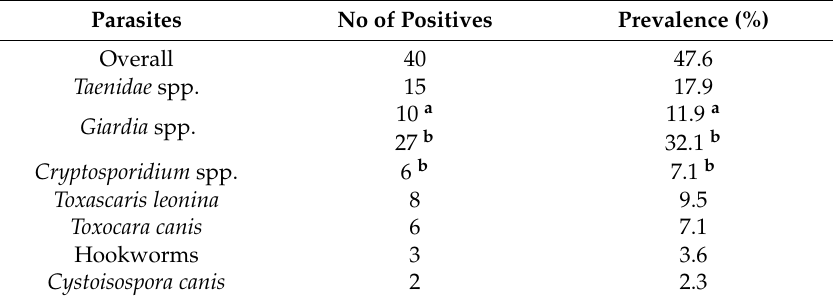
Table 1. Prevalence of gastrointestinal parasites in dogs ( n = 84) of Pine Ridge Reservation, South Dakota by fecal flotation and by immunofluorescence assay (FA) for Giardia spp. and Cryptosporidium spp.